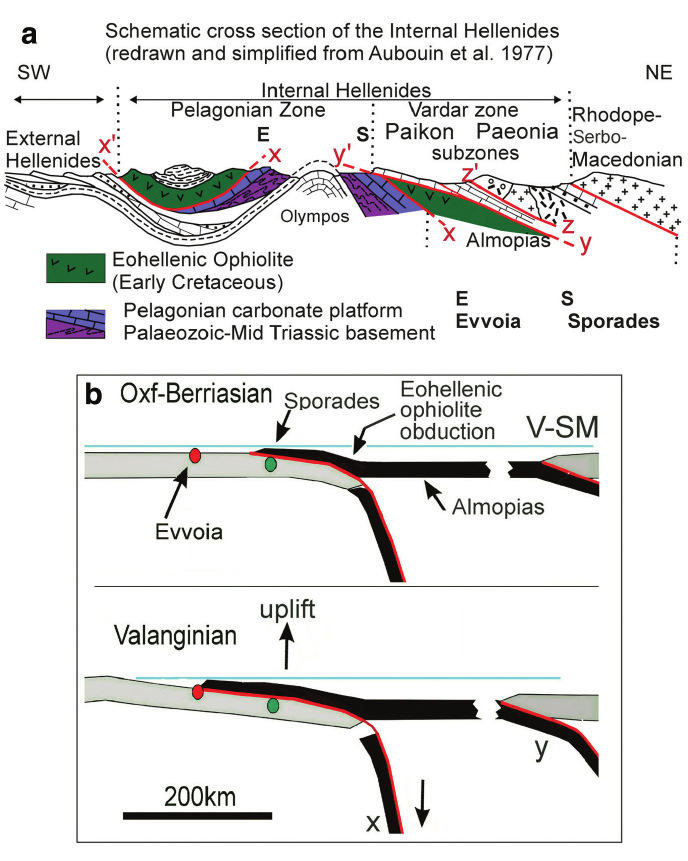
schematic cross section of the Internal hellenides (modified after aubouin et